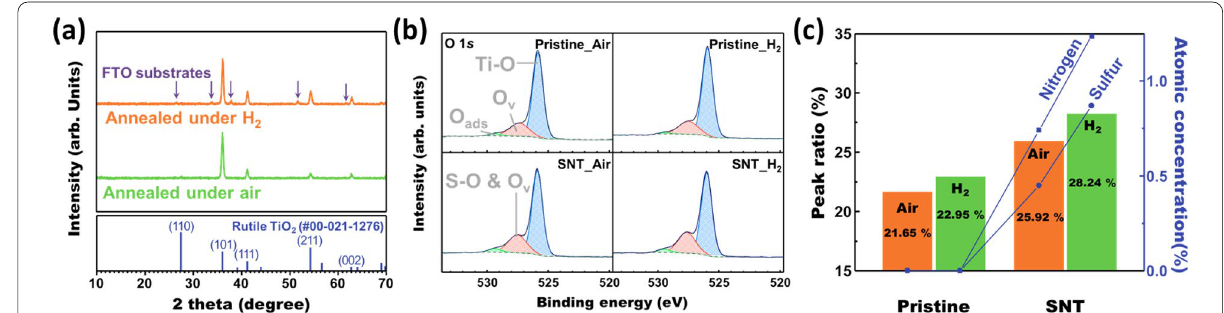
Fig. 7 a XRD spectra of the S, N doped TiO 2 nanorod arrays annealed under ambient air and H 2 atmosphere at 350 °C. b O 1 s XPS spectra of the optimum and reference samples. c Comparison chart including the Peak volume ratio between the S–O and O v and Ti–O bonding peak and the dopant concentration for the optimum and reference